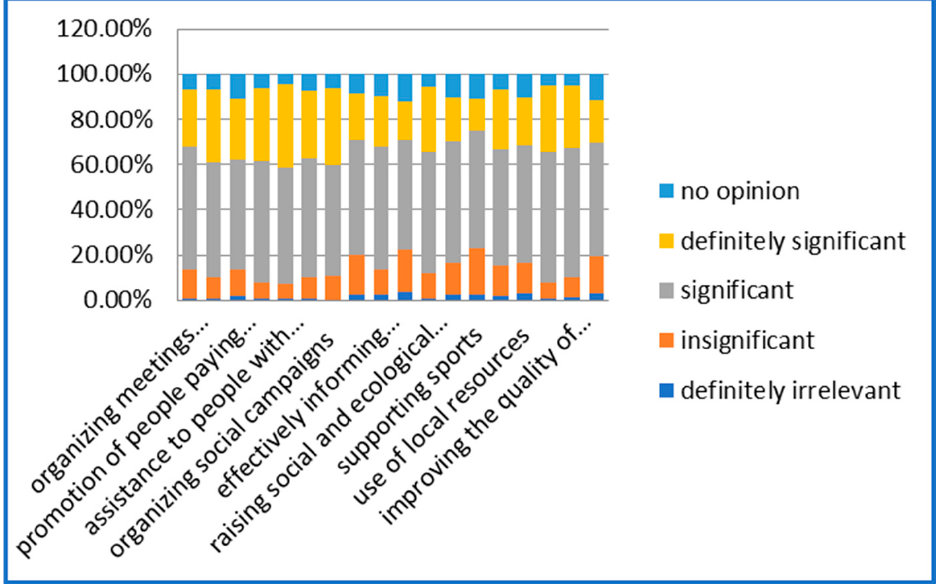
Figure 3. Actions undertaken in the sphere of local responsibility by ZGM TBS ( n = 362).